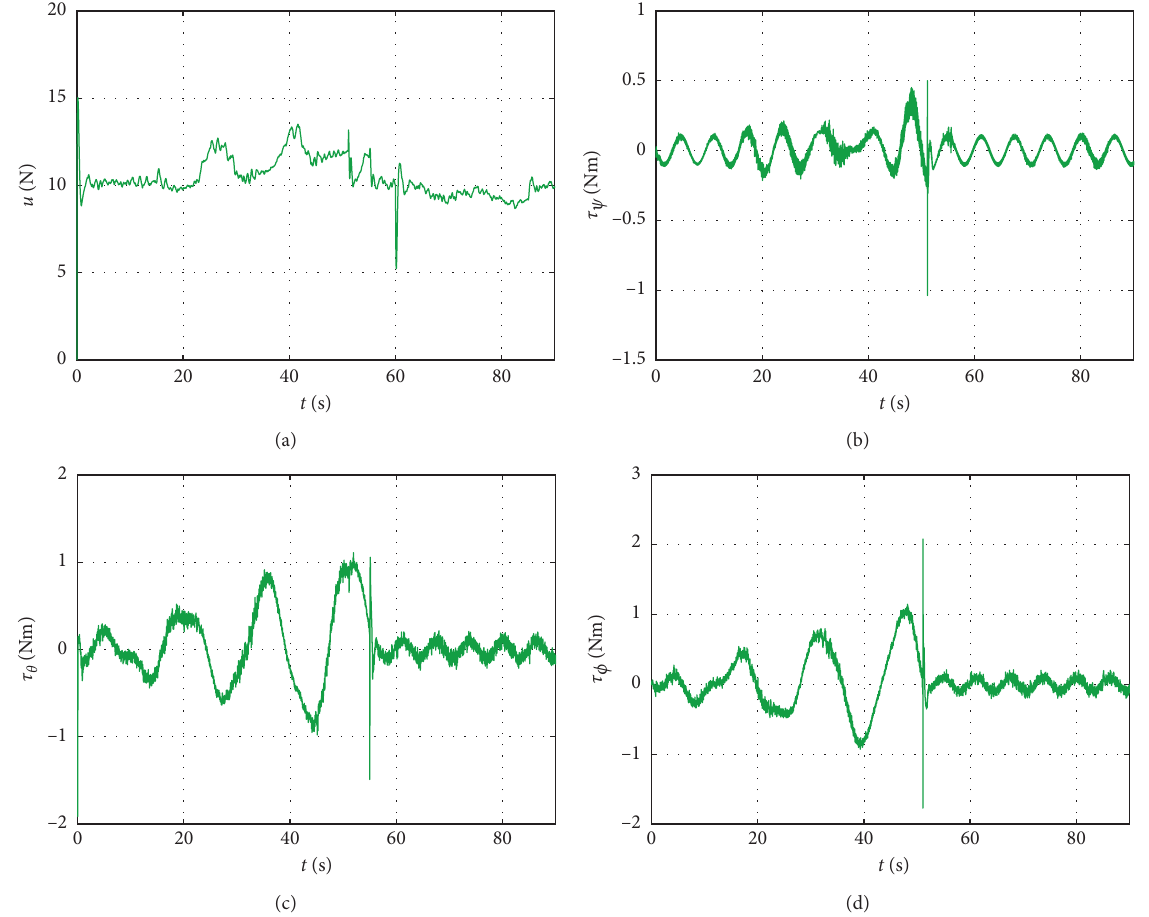
Figure 17: Robust control input signals computed in presence of high-frequency motion disturbances. (a) u . (b) τ